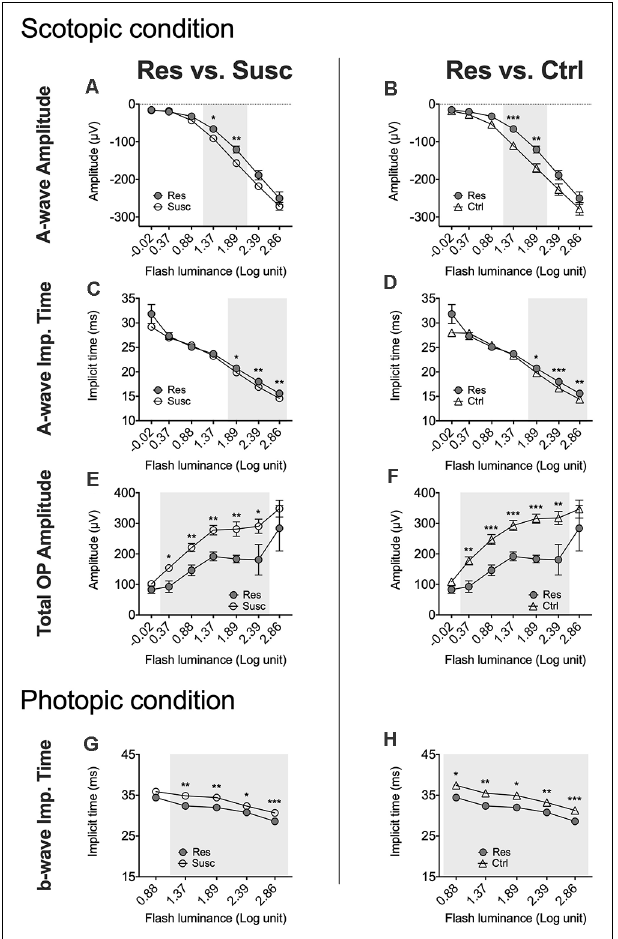
of the resilient vs. susceptible, and the resilient vs. control mice in males throughout every luminance step measured in scotopic ( − 0.02–2.86 log cd.s/m 2 ) and photopic (0.88 and 2.86 log cd.s/m 2 ) conditions. (A–H) Resilience-specific alterations were consistently found in rod a-wave amplitude (A,B) and implicit time (C,D) , in total rod OP amplitude (E,F) and cone b-wave implicit time (G,H) following CSDS. Significance was determined using linear mixed model analysis with LSD multiple comparisons test. Symbols and bars represent the group average ± SEM; * p < 0.05, ** p < 0.01, *** p < 0.001; n -values are given in the “Materials and